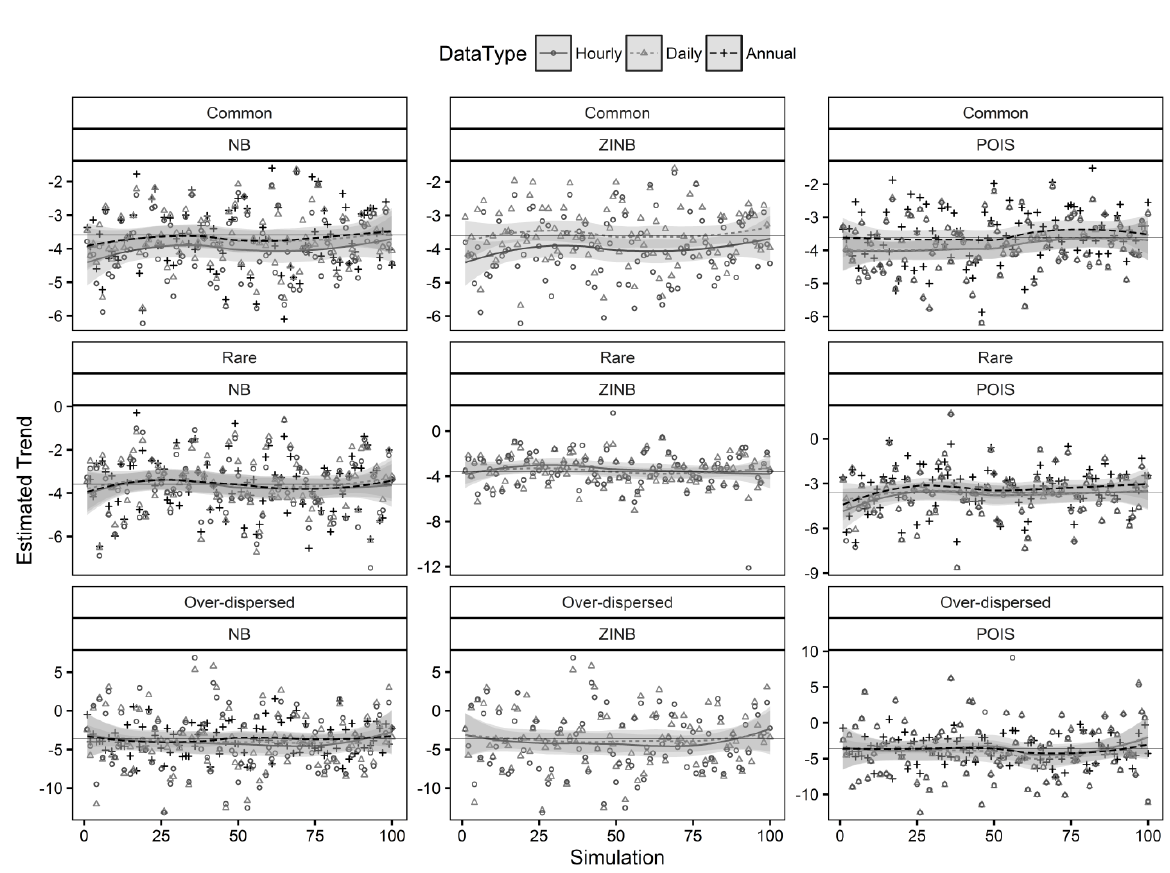
Figure A4.1. Scatter plots with loess smooth, showing estimated trend for each of 100 datasets simulated to represent a commonly detected species (e.g., Northern Harrier), a rarely detected species with zero-inflated counts (e.g., Peregrine Falcon) and a super-flocking species with highly over- dispersed counts (e.g., Broad-winged Hawk). Results are shown for trends estimated using hourly, daily and annual migration counts, and assuming a negative binomial (NB), zero-inflated NB (ZINB; hourly and daily data only), or Poisson (POIS) distribution of counts. The solid grey horizontal line depicts the true, simulated trend of -3.6%year -1